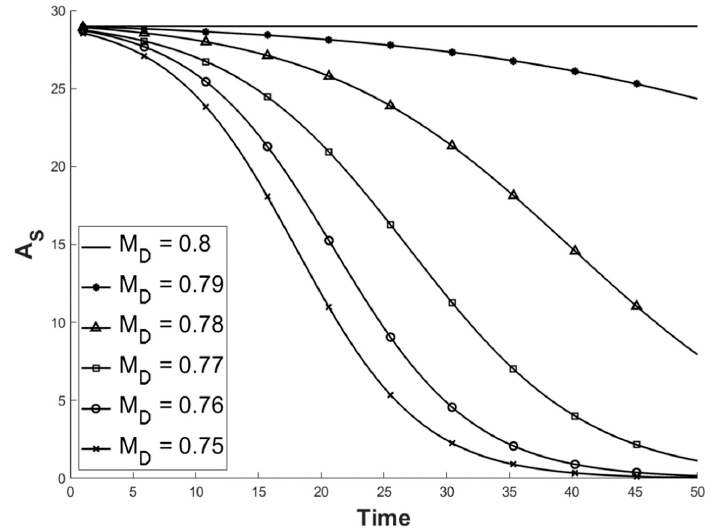
Figure 5. Illustration of the predicted values for A S with di ff erent disease-induced mortality rates, while other values remained constant at: Ψ = 0.45; σ = 0.3; M N = 0.2; the starting population comprised of A I = 1 and As = 29. A s is the number of susceptible individuals, Ψ is the contact rate, σ is the likelihood of transmission, M N is the natural mortality rate and M D is the mortality rate associated with